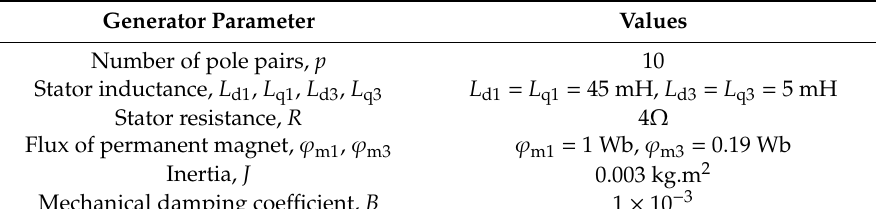
Table 2. Parameter configuration of the generator in the simulations.